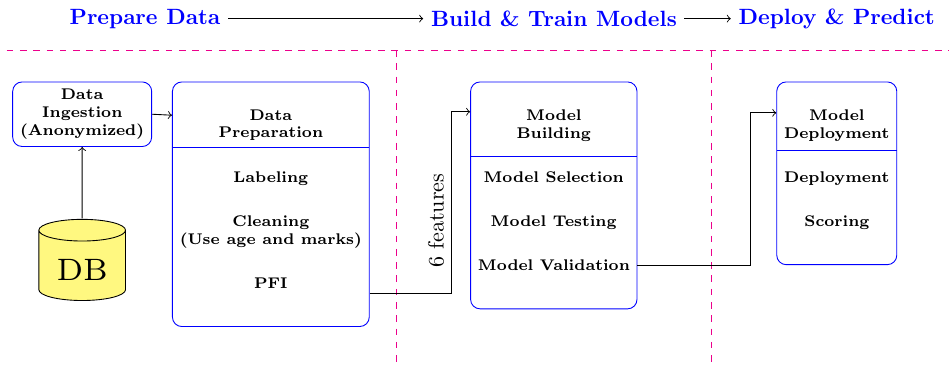
Figure 2. Machine learning modularization pipeline.